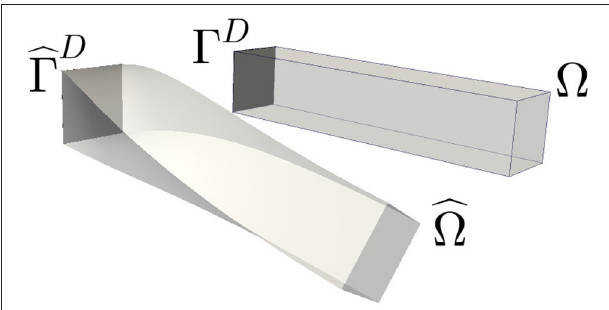
FIGURE 1 | The undeformed body (cid:127) (right) and the deformed body (left). Both have in common the portion of the boundary Ŵ D body is